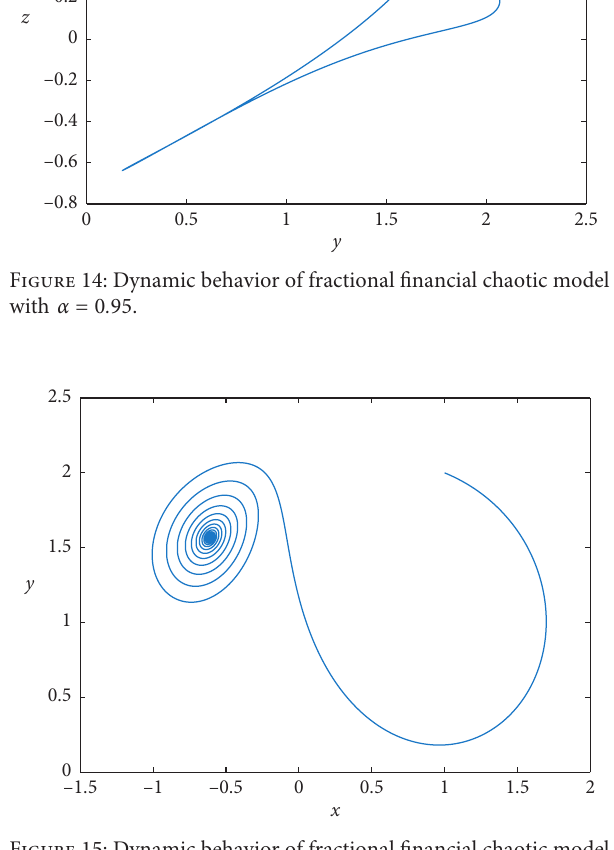
Figure 15: Dynamic behavior of fractional financial chaotic model with α � 0 .